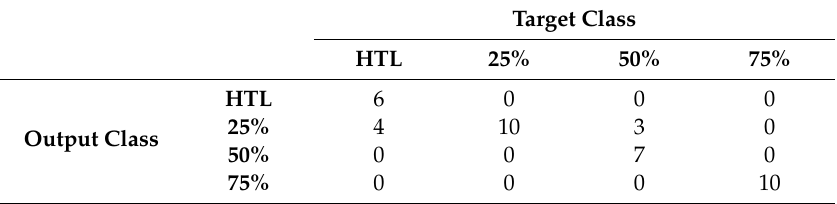
Table 8. Confusion matrix for the validation of the ANN classifier with vibration